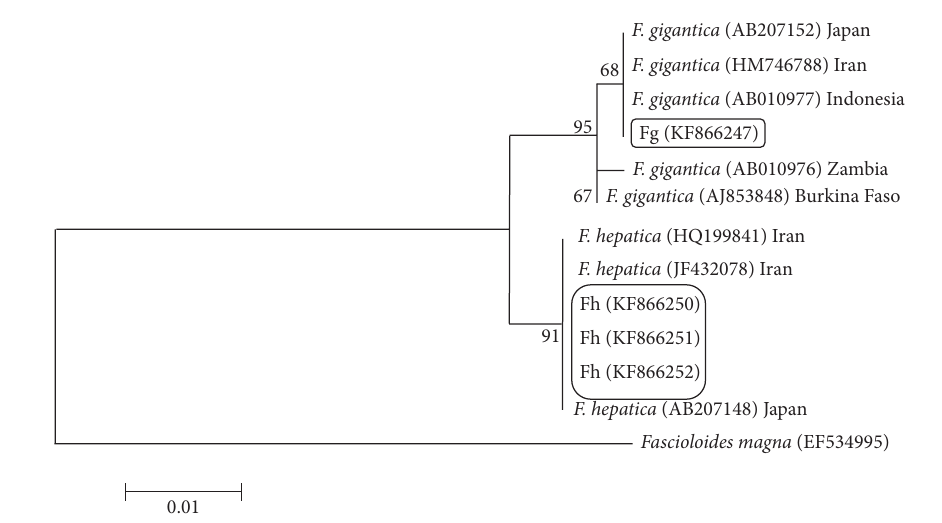
Figure 5: Phylogenetic relationship of ITS1 sequences of isolates of Fasciola hepatica and Fasciola gigantica from Iran using Maximum Likelihood method. Fascioloides magna (AN: EF051080) was used as the out group.